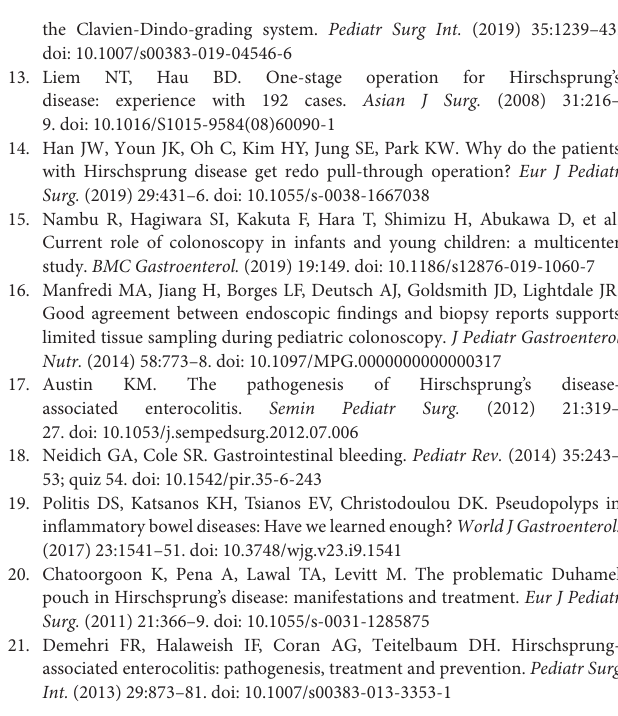
Supplementary Video 3 | Blind rectal